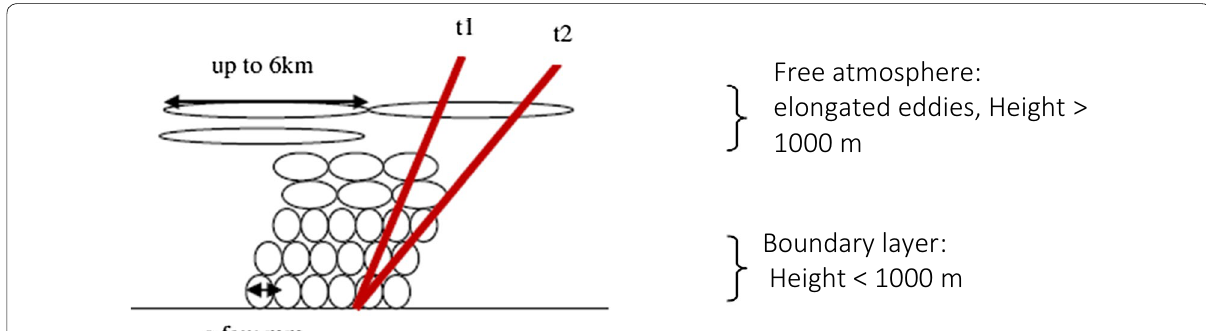
Fig. 4 GNSS signal path through the turbulent troposphere using the concept of isotropic eddies in the boundary layer and anisotropic two-dimensional structure in the free atmosphere. t 1 and t 2 are two epochs of measurements. The figure is adapted from Kermarrec and Schön (2014)